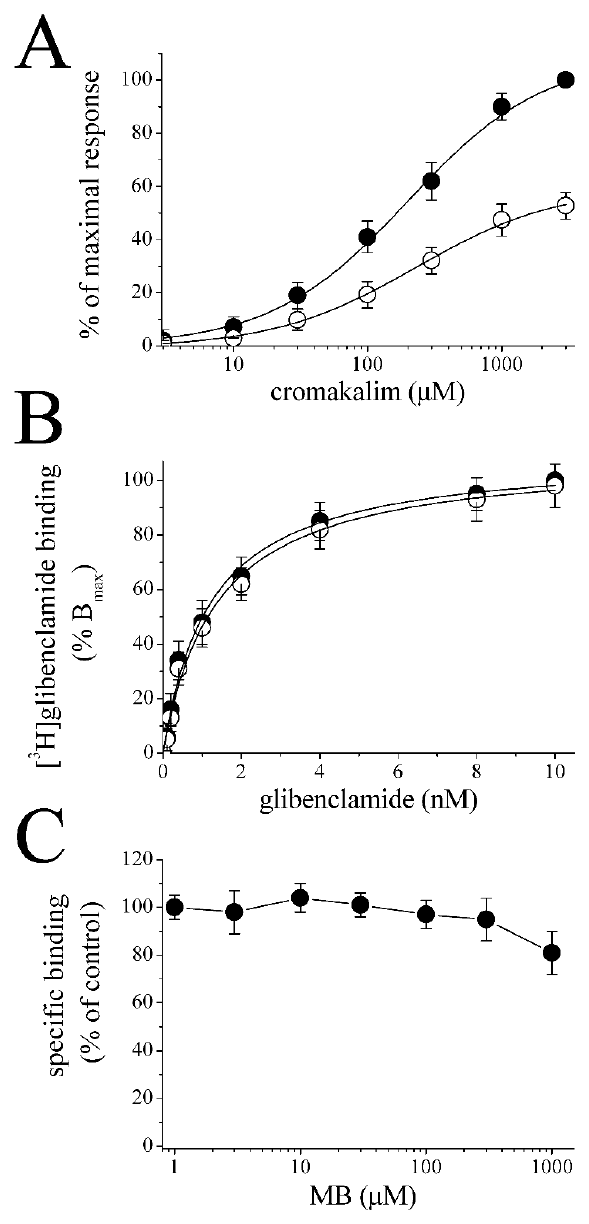
Figure 3. The effects of MB on the cromakalim dose-response curve and the specific binding of [ 3 H]glibenclamide. ( A ) Concentration-response curves for cromakalim-activated currents in the absence ( filled circles ) and presence ( open circles ) of MB (30 µ M). MB was administered for 20 min, and cromakalim and MB were then co-administered for 2 min. Data points represent the mean ± S.E.M. ( n = 5–6; error bars not visible are smaller than the size of the symbols). Curves show the best fit of the data to the logistic equation presented in the methods section. The concentration-response curves are normalized to maximal control cromakalim response. ( B ) Specific binding as a function of the concentration of [ 3 H]glibenclamide in the absence ( filled circles ) and presence of 30 μM MB ( open circles ). Data represent the means of four experimental measurements. The incubation time was 60 min at 22 °C, pH 7.5. In order to determine nonspecific binding, samples were incubated with 10 nM of unlabeled glibenclamide. ( C ) Increasing concentrations of MB do not alter the specific binding of [ 3 H]glibenclamide (1 nM). Data represent the results of 4 – 5 experiments. Data points show means ± SE.M. Microsomal membranes were incubated with 1 nM [ 3 H]glibenclamide (0.3 – 0.5 mg/mL for 60 min) with increasing concentrations of MB in the medium. Free and bound [ 3 H]glibenclamide were separated by filtration. MB: methylene blue.